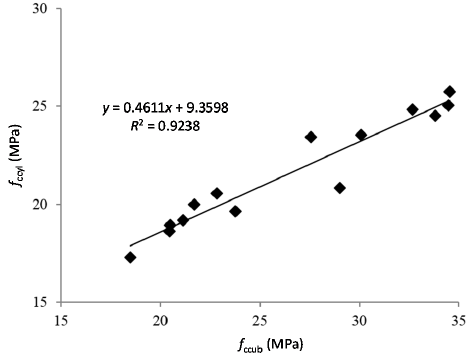
Figure 4. Correlation between compressive strength values for cylinder and cubic specimens at 28 days. Table 7 indicates the mean splitting tensile strength values for each concrete mixture.